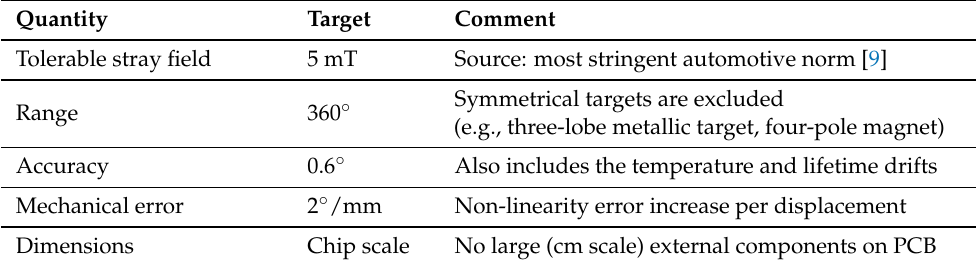
Table 1. Target requirements.